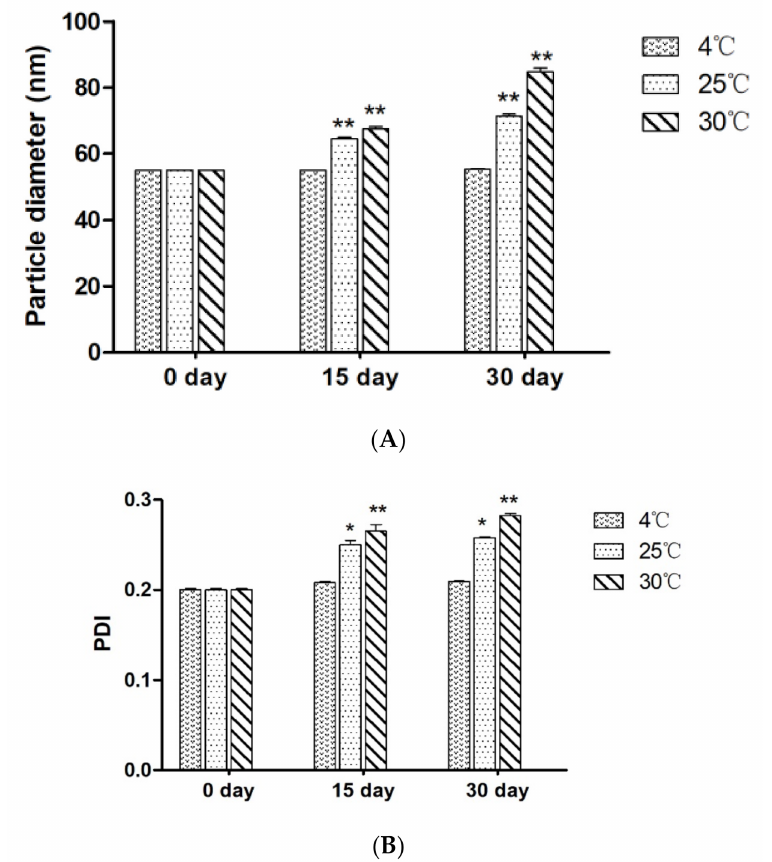
Figure 3. Effect of different temperatures on the particle size ( A ) and PDI ( B ) during storage for 15 and 30 days at temperatures 4, 25 and 30 ◦ C. Data are given as mean ± SD, n = 3. Compared with the size and PDI at the beginning, * ( p < 0.05) means the difference. ** ( p < 0.01) means the significant